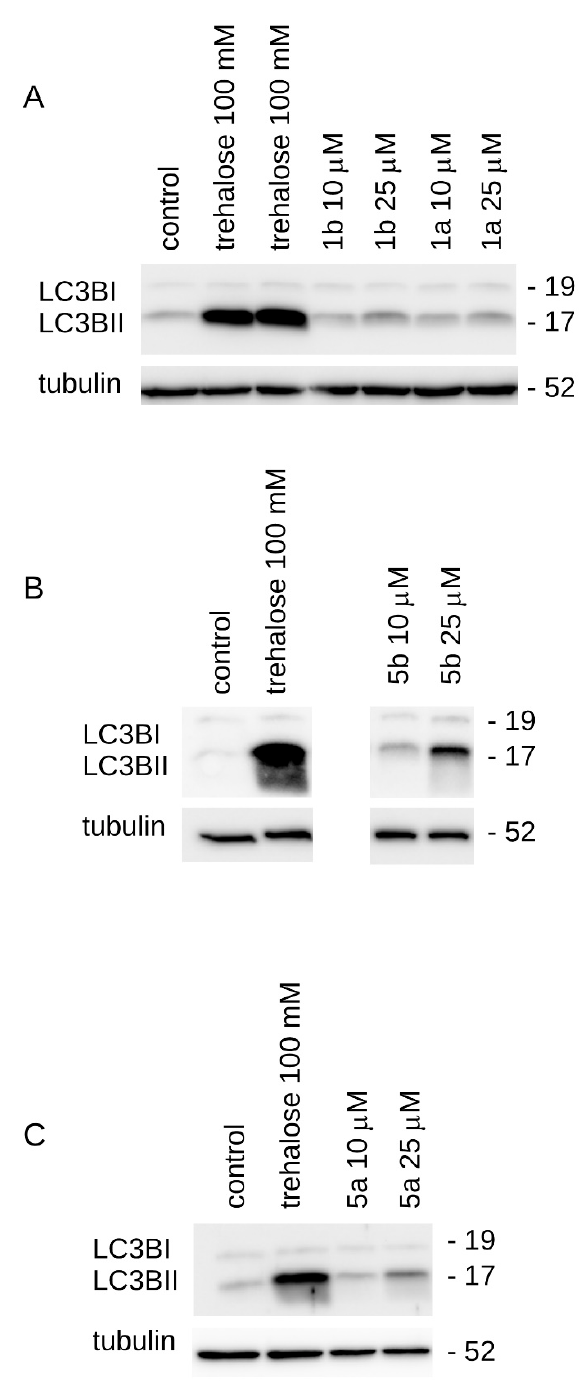
Figure 2. Biological activity of trehalose, conjugates 1a and 1b and NAs 5a and 5b . We assessed LC3B conversion upon compound treatment by Western blotting. ( A ) Evaluation of autophagy induction in HeLa cells treated for 24 h with trehalose, 1b and 1a . Upon treatment, we analyzed tubulin, LC3BI and II levels by Western blotting. ( B ) Evaluation of autophagy induction in HeLa cells treated for 24 h with trehalose and 5b . Upon treatment, we analyzed α -tubulin, LC3BI and II levels by Western blotting. ( C ) Evaluation of autophagy induction in HeLa cells treated for 24 h with trehalose and 5a . Upon treatment, we analyzed α -tubulin, LC3BI and II levels by Western blotting.